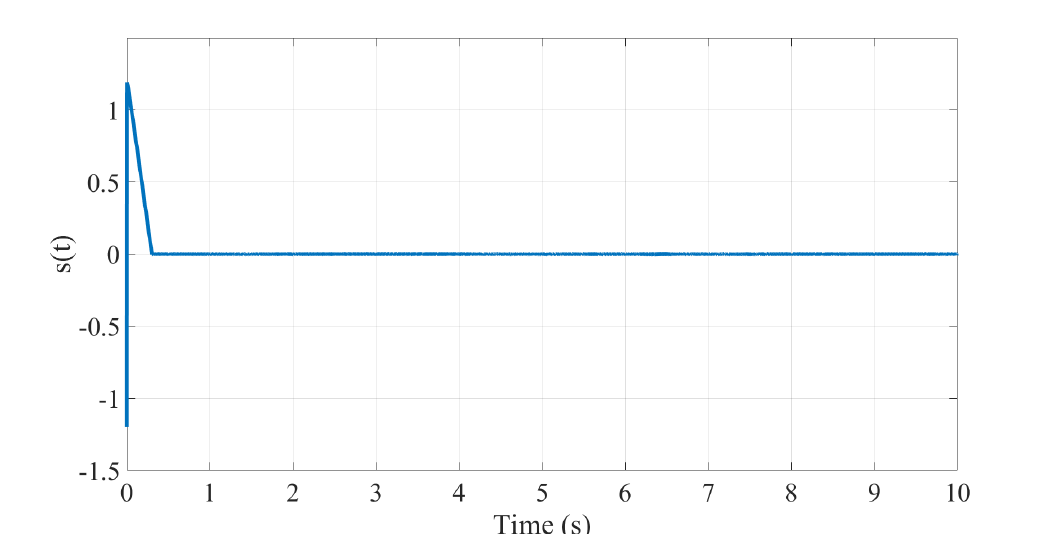
Figure 19. Sliding surface SMC and upper bounds known with constant